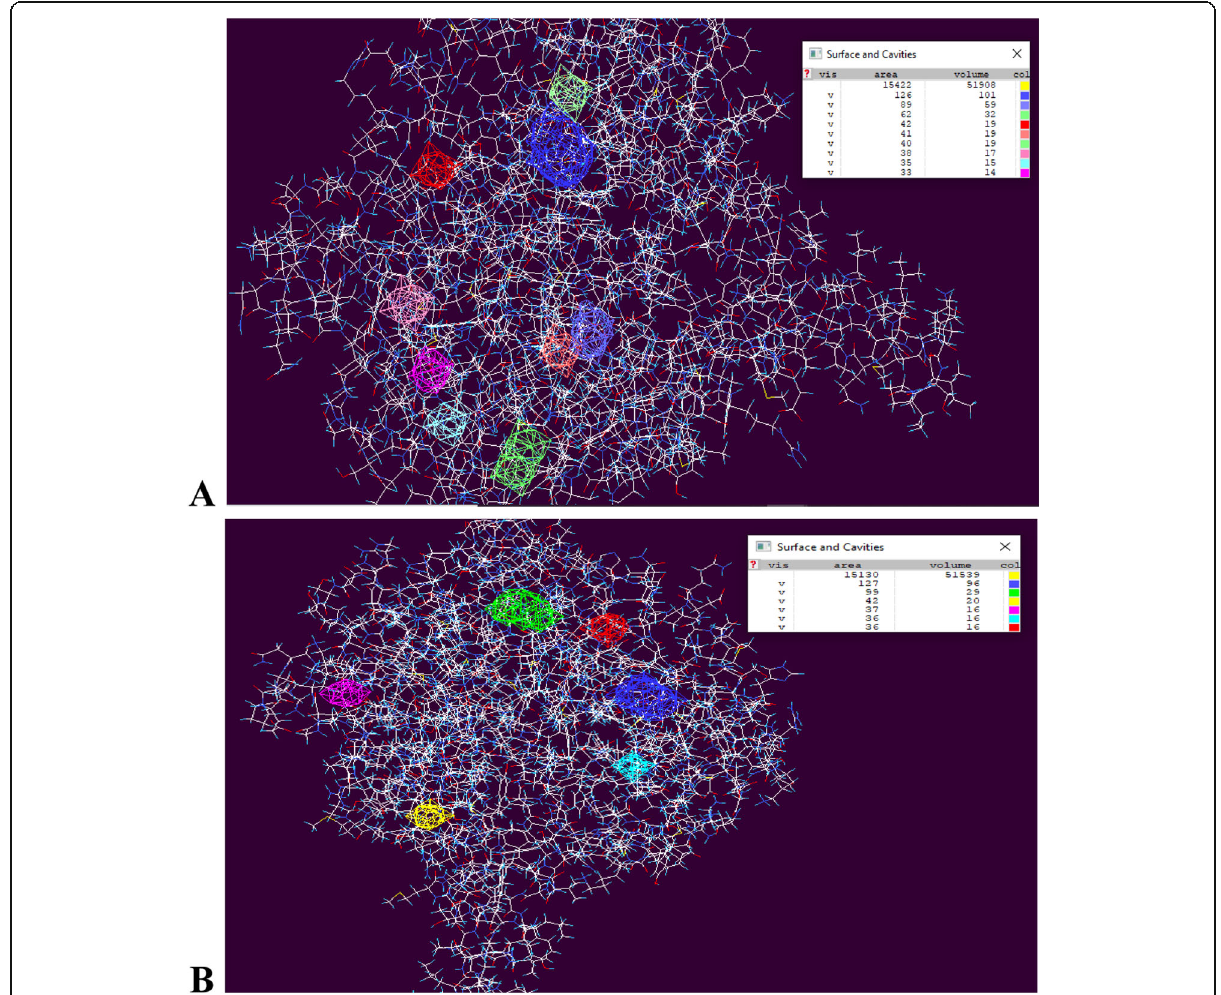
Fig. 4 a: Wild type NSDHL protein structure with nine active sites, b Mutant NSDHL protein structure with only six active